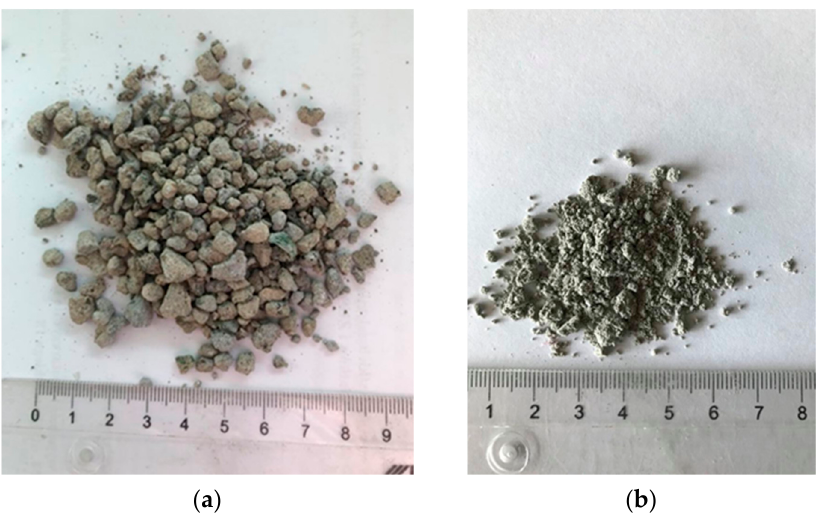
Figure 4. Municipal solid waste incineration plant secondary waste: ( a ) Slag after valorization; ( b ) Fly ash.